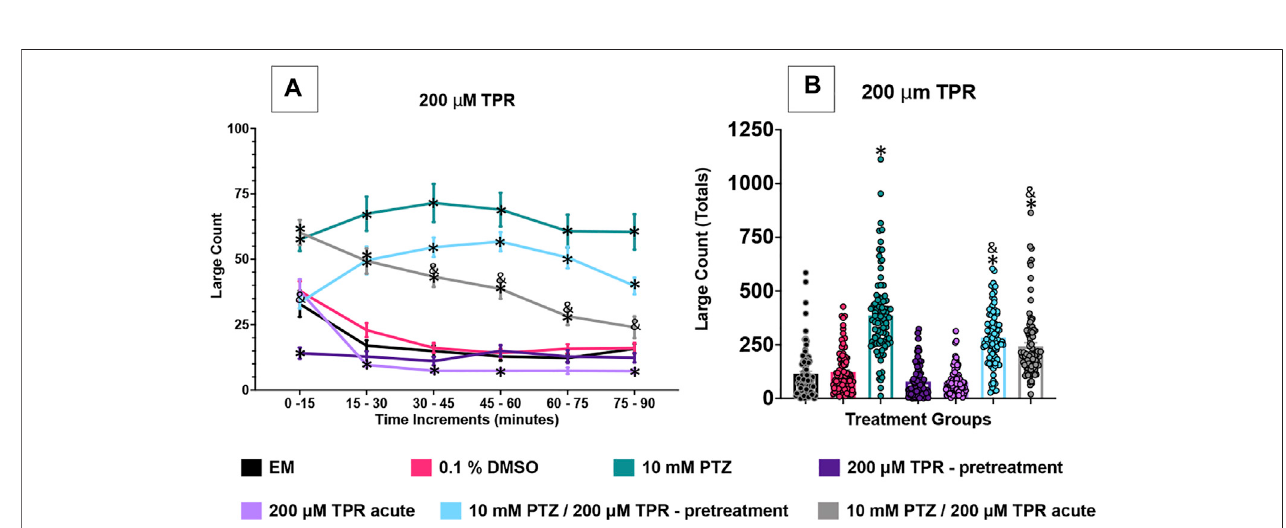
FIGURE 4 | Behavioral pro fi le of zebra fi sh larvae exposed to topiramate. (A) The average large count ( y -axis) of larvae is depicted per 15 min interval ( x -axis) of the tracking session. The respective treatment groups ( x -axis). Analyses (two-way ANOVA, Tukey ’ s post-hoc) are marked * ( p < 0.05) to indicate signi fi cant differences to embryomedium (EM).Standarderrorofthemeansisshown.Analyses(two-wayANOVA, Tukey ’ spost-hoc) aremarked&( p < 0.05)toindicatesigni fi cantdifferencesto 10 mMPTZ. (B) Thetotallargecount( y -axis)over90 minisdisplayed.Therespectivetreatmentgroups( x -axis).Analyses(one-wayANOVA,Tukey ’ spost-hoc)are marked* ( p < 0.05) toindicate signi fi cantdifferences toembryo medium (EM).Standarderror ofthemeansisshown. Analyses (one-way ANOVA, Tukey ’ spost-hoc) are marked & ( p < 0.05) to indicate signi fi cant differences to 10 mM PTZ. ( n = 91 fi sh/treatment group).